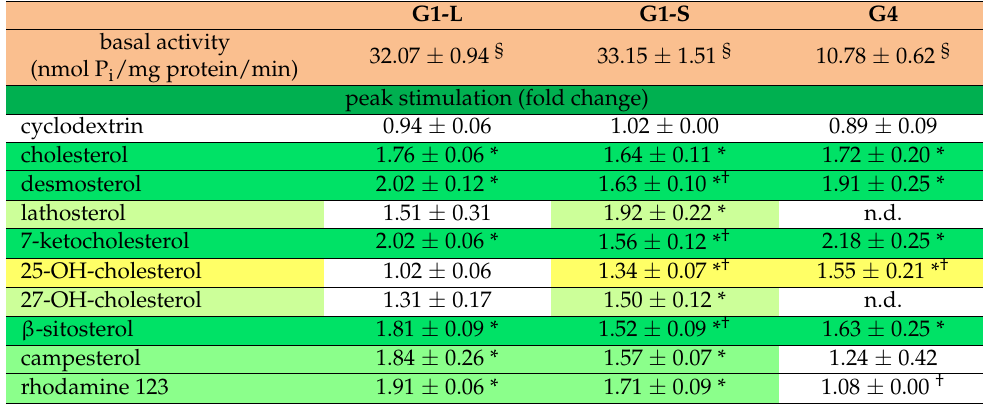
dark green—stimulation of all three ABCG proteins; light green—stimulation of both isoforms of ABCG1; yellowish green—stimulation of G1-S only; yellow—stimulation of G1-S and G4. § significant difference as compared to the activity of β -gal-containing membranes (6.04 ± 1.40 nmol P i /mg/min); * significant difference from 1, i.e., peak stimulations are compared to basal activities; † significant difference as compared to the